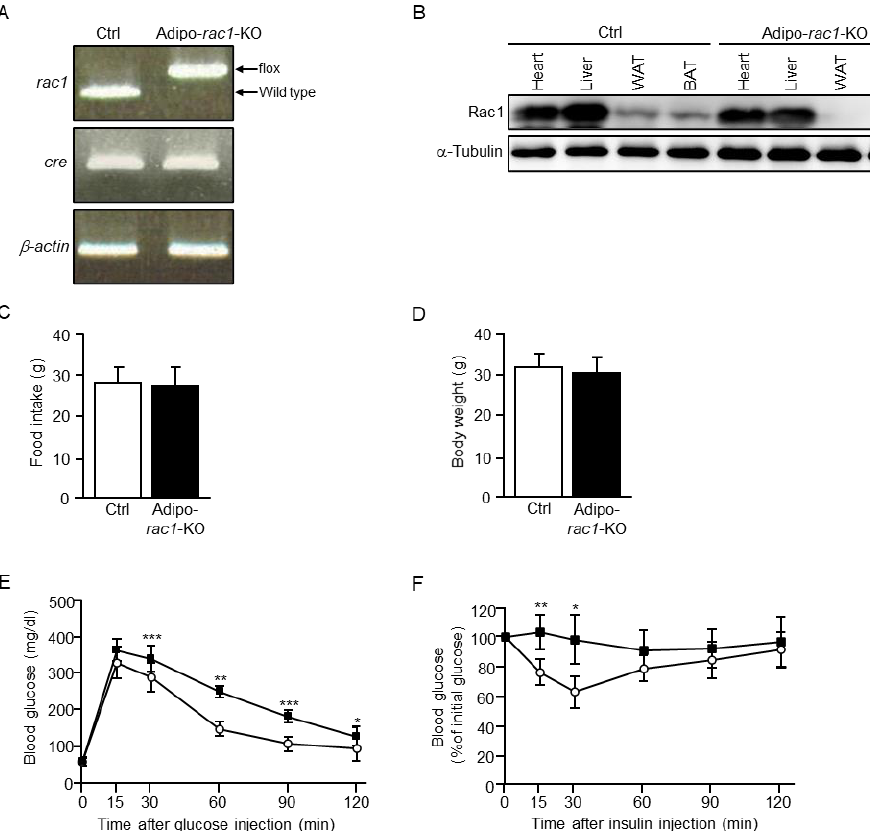
Figure 1. The generation of adipo- rac1 -KO mice. ( A ) Genotyping of control (Ctrl, Adipoq-Cre transgenic) and adipo- rac1 -KO ( rac1 flox/flox ; Adipoq-Cre) mice. Positions of polymerase chain reaction (PCR) products from wild-type and floxed alleles of the rac1 gene are indicated. ( B ) Expression of Rac1 and α-tubulin (loading control) in various tissues of control and adipo- rac1 -KO mice. Rac1 and α-tubulin were visualized by immunoblot analysis using anti-Rac1 and anti-α-tubulin antibodies, respectively. ( C ) Food intake (per week) in 26-week-old control and adipo- rac1 -KO mice. Data are shown as means ± S.E. ( n = 10). ( D ) Body weight in 26-week-old control and adipo- rac1 -KO mice. Data are shown as means ± S.E. ( n = 10). ( E ) Intraperitoneal glucose tolerance test in 26-week-old control (white circle) and adipo- rac1 -KO (black square) mice. Data are shown as means ± S.E. ( n = 5). * p < 0.05, ** p < 0.01, *** p < 0.001. ( F ) Intraperitoneal insulin tolerance test in 26-week-old control (white circles) and adipo- rac1 -KO (black squares) mice. Data are shown as means ± S.E. ( n = 5). * p < 0.05, ** p <